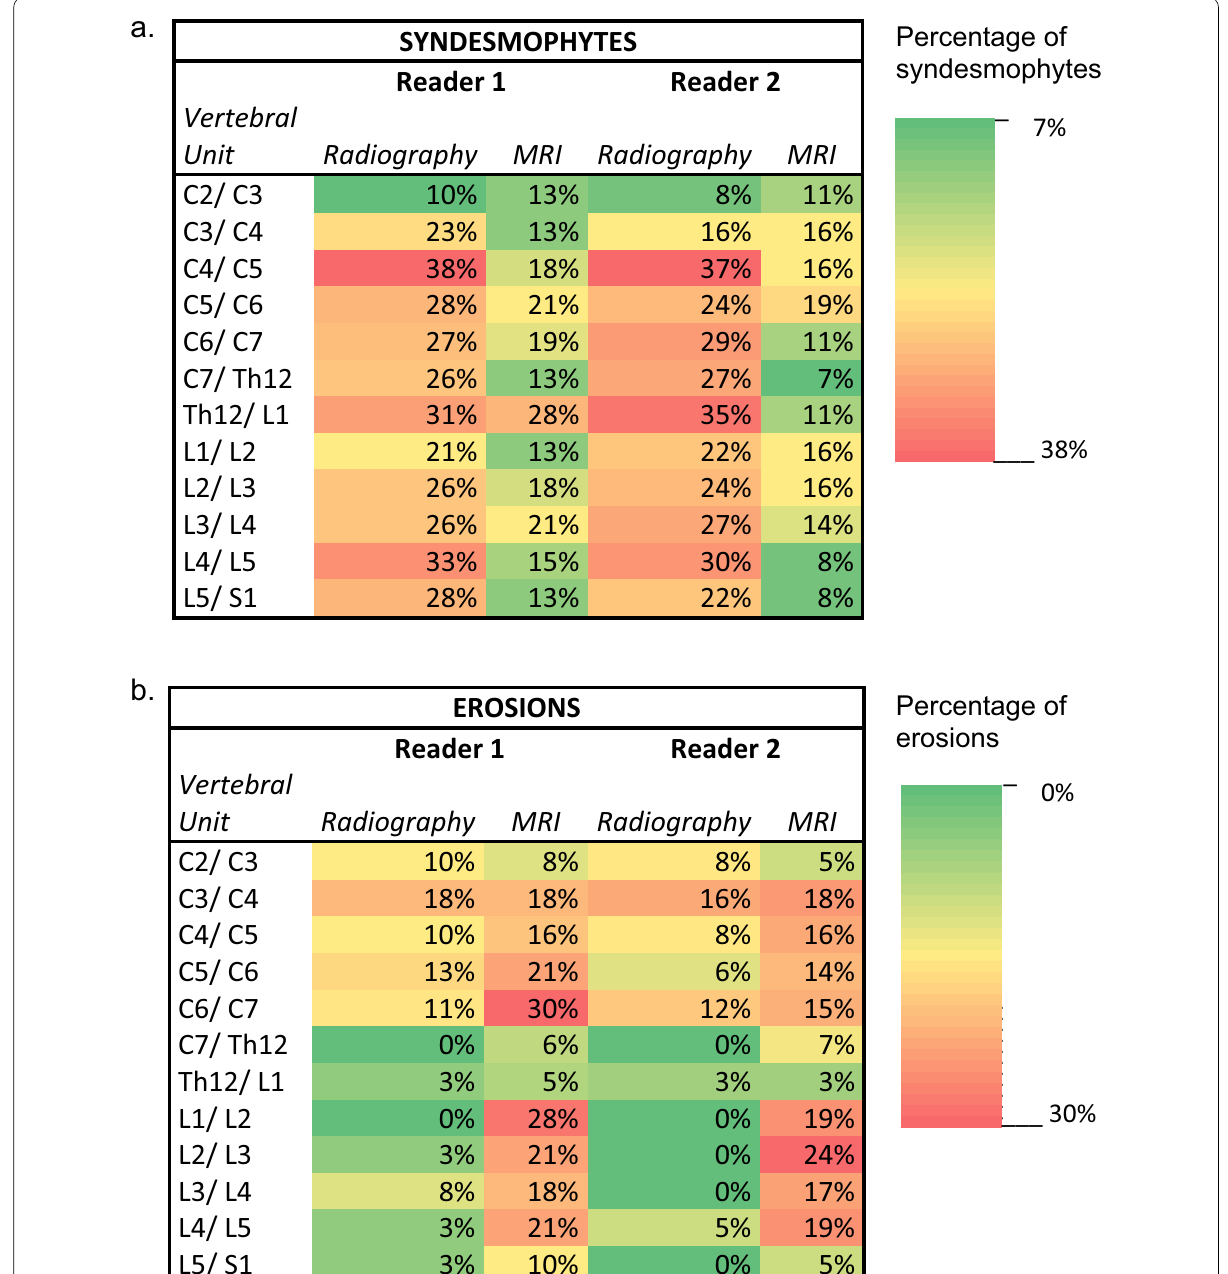
Fig. 1 Heatmaps of reported syndesmophytes ( a ) and erosions ( b ) found on radiography and MRI for each reader. a Percentages in the heatmaps represent the proportion of reported findings in the study population. b Percentages in the heatmaps represent the proportion of reported findings in the study